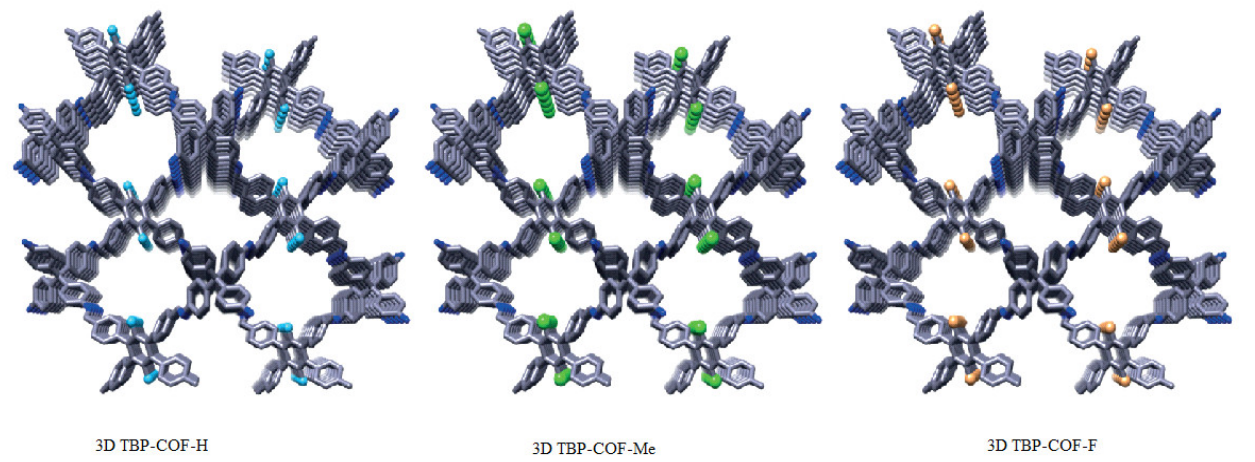
Figure 8. Geometrical representation of the structures [43].